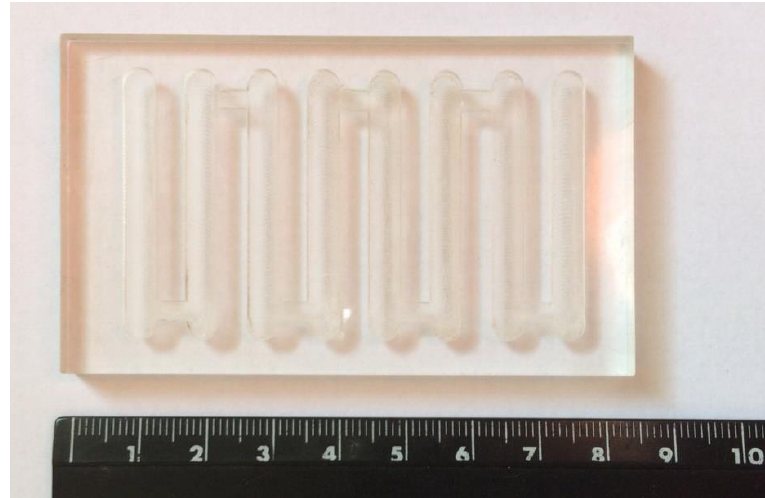
Figure 5. Modified Bogorov’s chamber for protozoa counting, 1 mL volume.